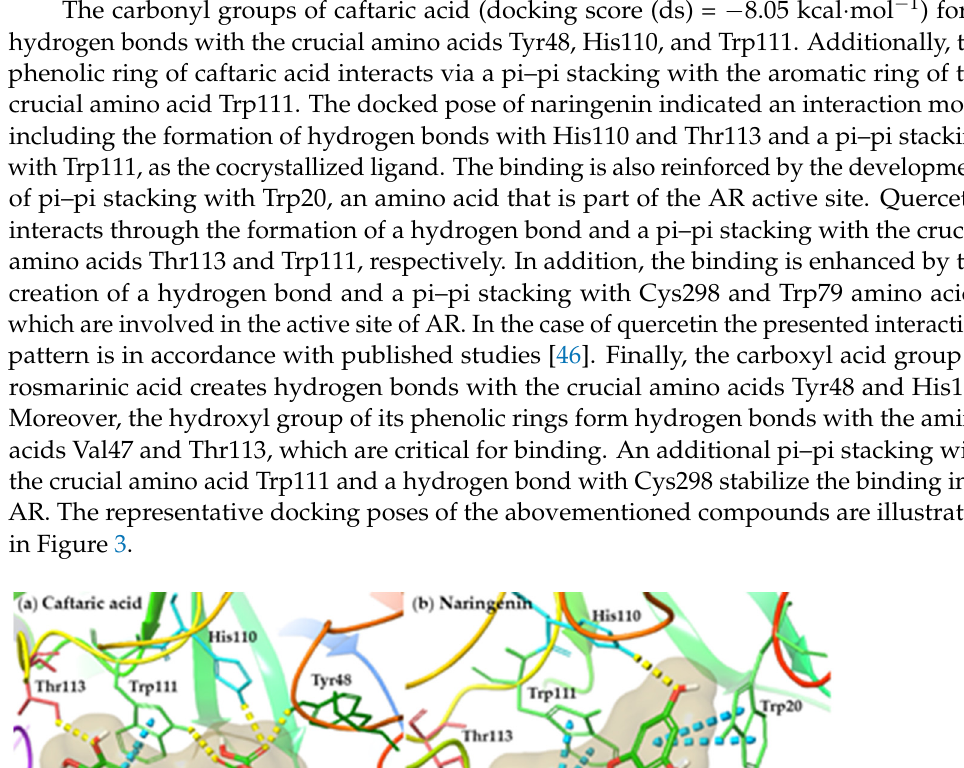
Figure 2. Chemical structures of caftaric acid, naringenin, quercetin, and rosmarinic acid.